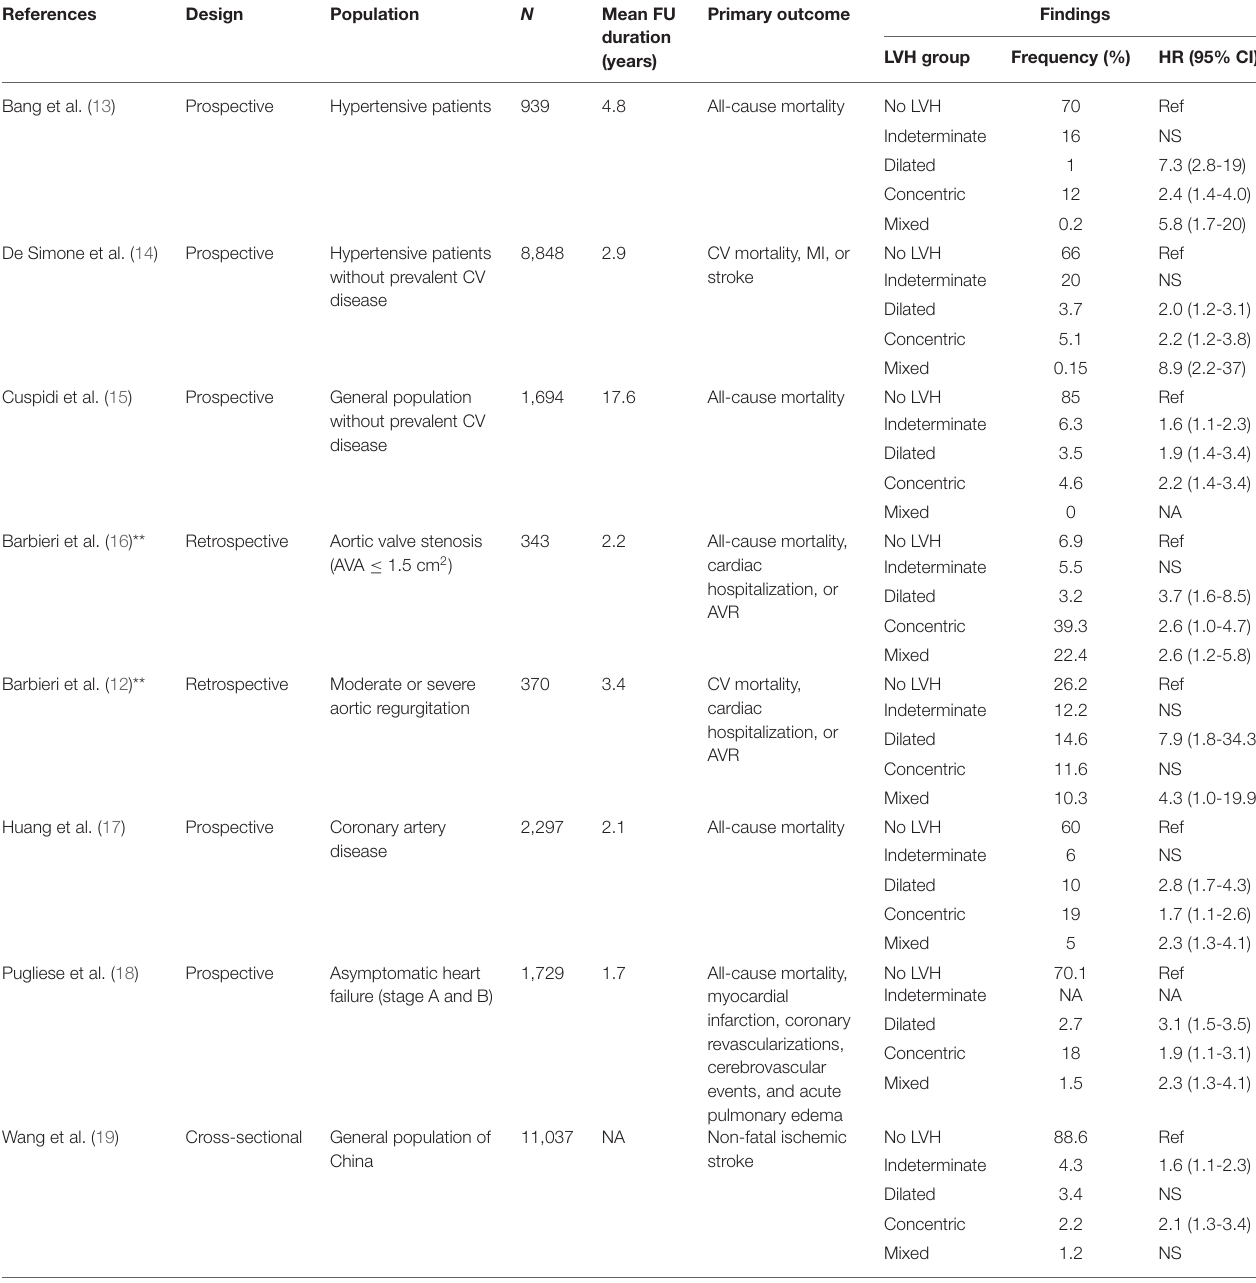
TABLE 1 | Summary of echocardiographic studies assessing the association of the 4-group left ventricular hypertrophy classification with cardiovascular